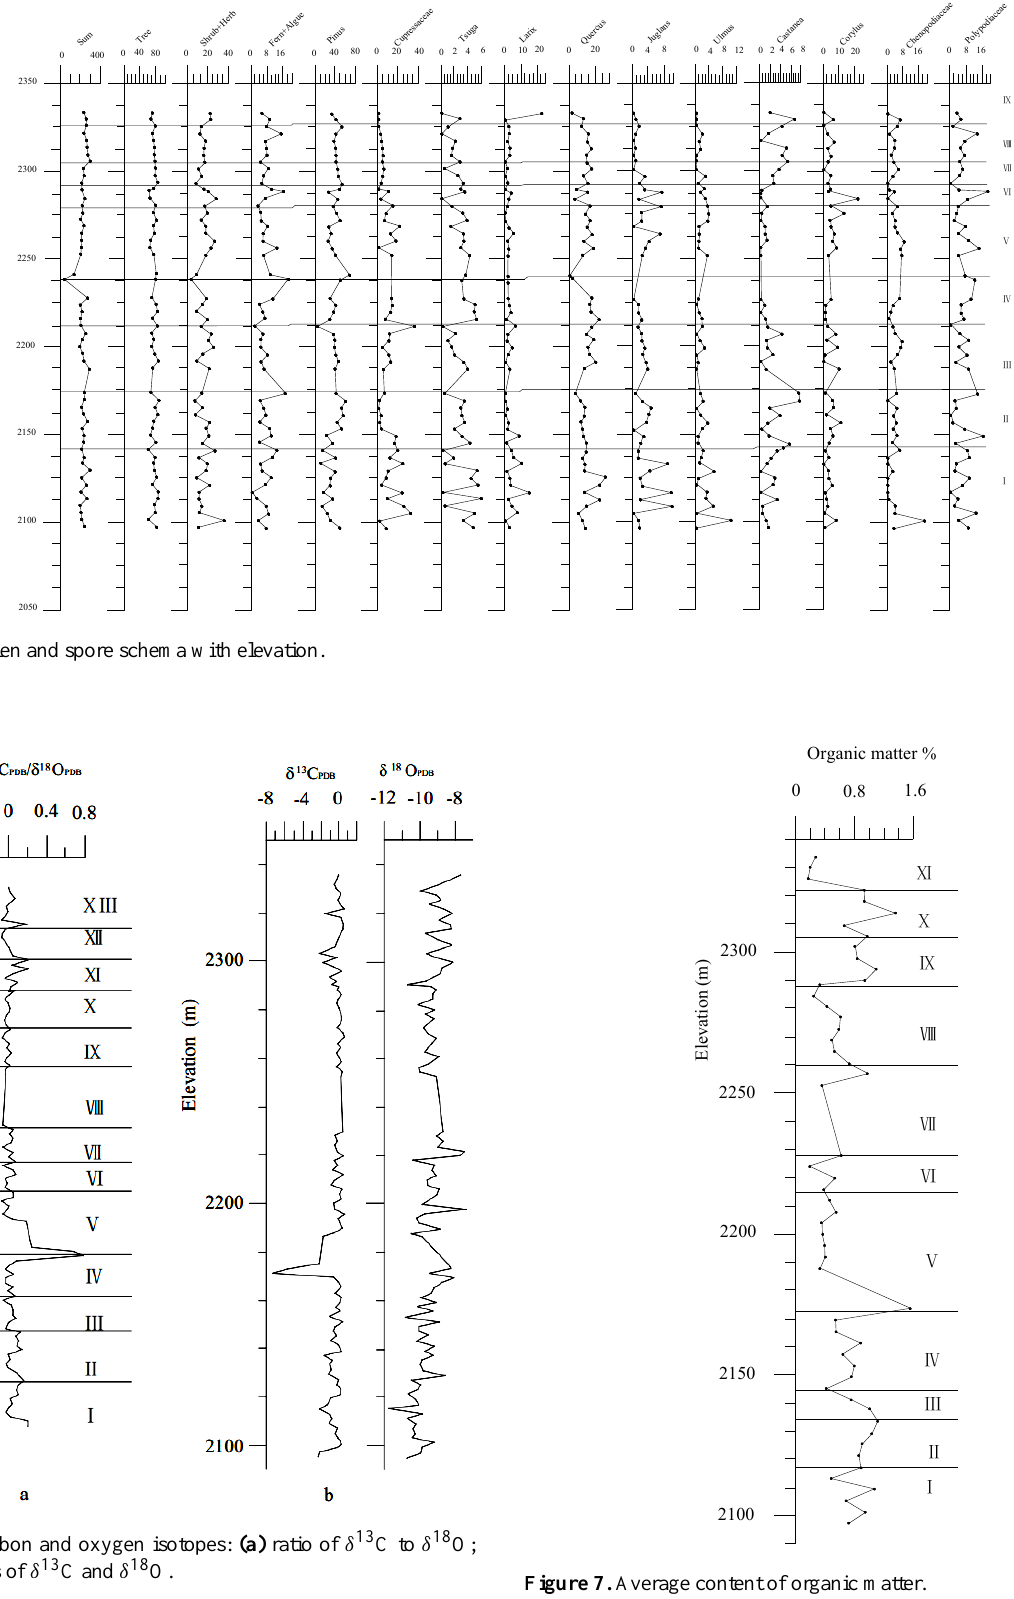
Figure 7. Average content of organic